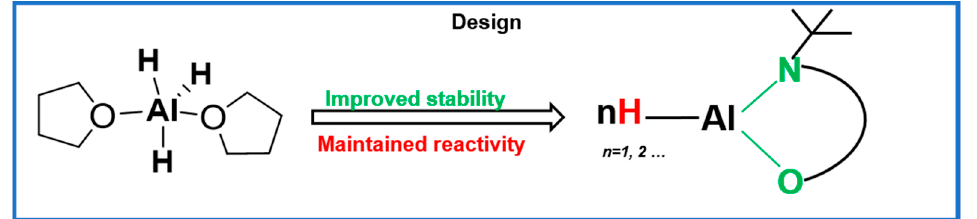
Scheme 1. Design of aluminium hydride compounds by ligand modification, manipulating volatil- ity and electronic properties of molecular